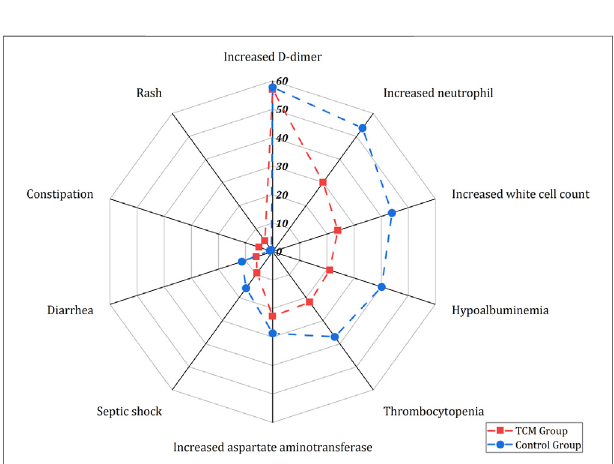
FIGURE 6 | Summary of adverse